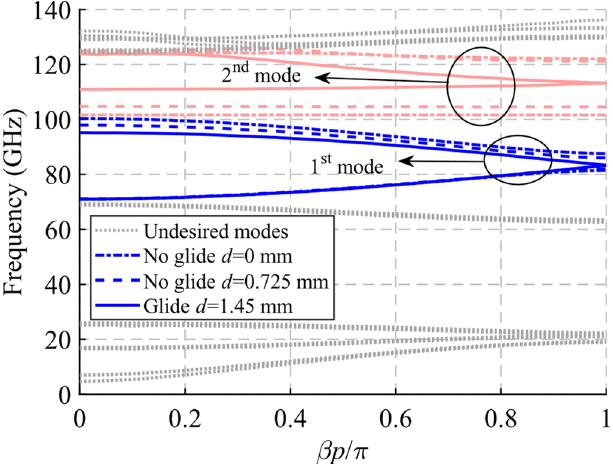
Figure 26. Dispersion diagram of the single periodic final unit cell for different stages of break of symmetry.